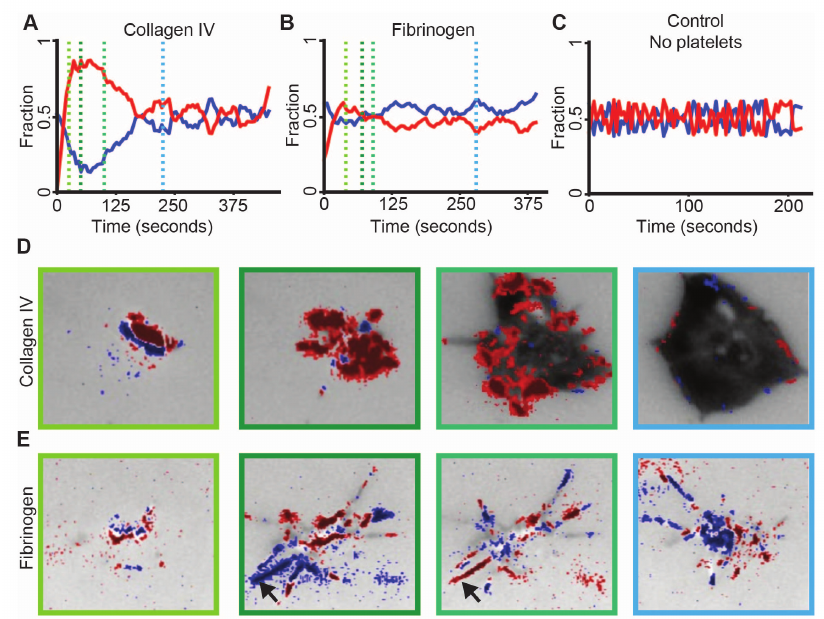
Figure 3. Differential platelet spreading: collagen IV versus fibrinogen. ( A – C ) Temporal profile of the fraction of attachment (red) versus detachment (blue) events during platelet spreading: ( A ) collagen-IV substrate, ( B ) fibrinogen substrate, ( C ) control – region with no platelet. ( D and E ) Spatiotemporal dynamics of attachment (red) versus detachment (blue) events during platelet spreading. Time corresponds to the vertical dashed line in panels A – B correspondingly: ( D ) Collagen-IV substrate. Platelet spreading is characterized by attachment, initially throughout the cell and later at the platelet periphery. ( E ) Fibrinogen substrate. Platelet spreading is characterized by the attachment and detachment of entire filopodia structures (arrow heads).